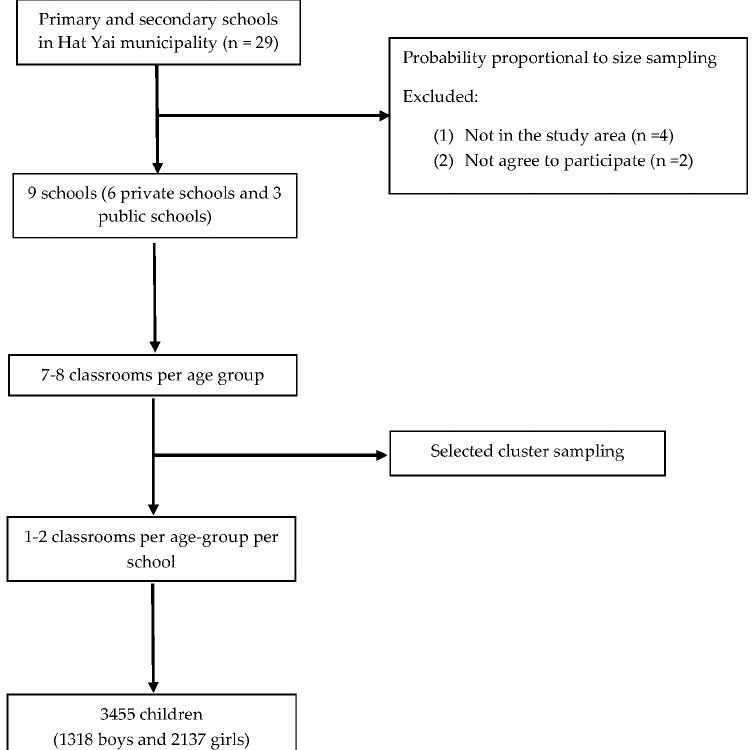
Figure 1. Flow chart of the study process, wherein participants were randomly selected by probability-proportional-to-size sampling.